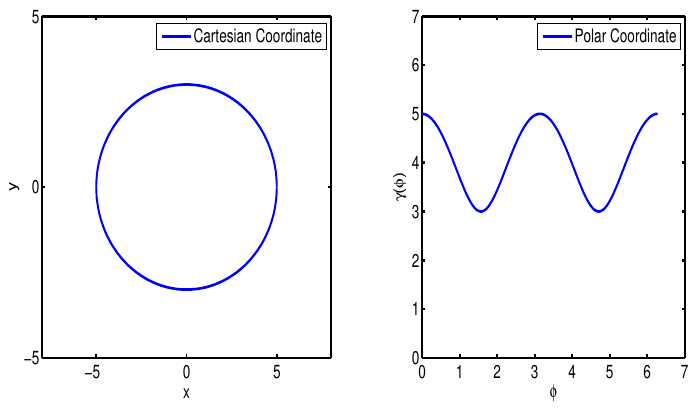
Figure 2. Example of star-convex